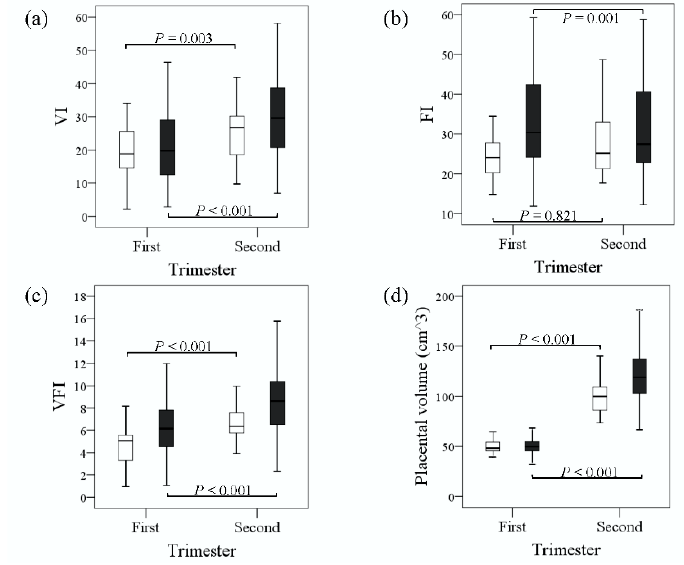
Figure 3. Box-and-whisker plots of ( a ) VI, ( b ) FI, ( c ) VFI, and ( d ) placental volume during the first and second trimesters in the SGA ( □ ) and control ( ■ ) groups. VI: vascularization index; FI: flow index; VFI: vascularization flow index. Boxes show median and interquartile range, and whiskers represent 5th and 95th centiles.